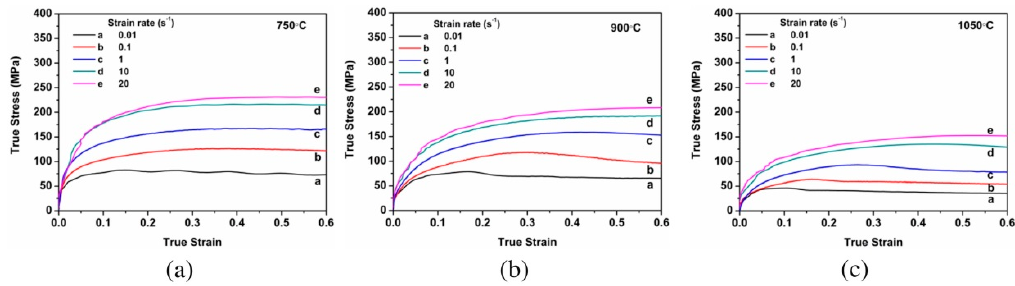
Figure 12. Flow curves of AISI 1010 steel in compression obtained using different strain rates after austenitization at 1050 °C for 5 min and at deformation temperatures of ( a ) 750 °C, ( b ) 900 °C, and ( c ) 1050 °C [80] .